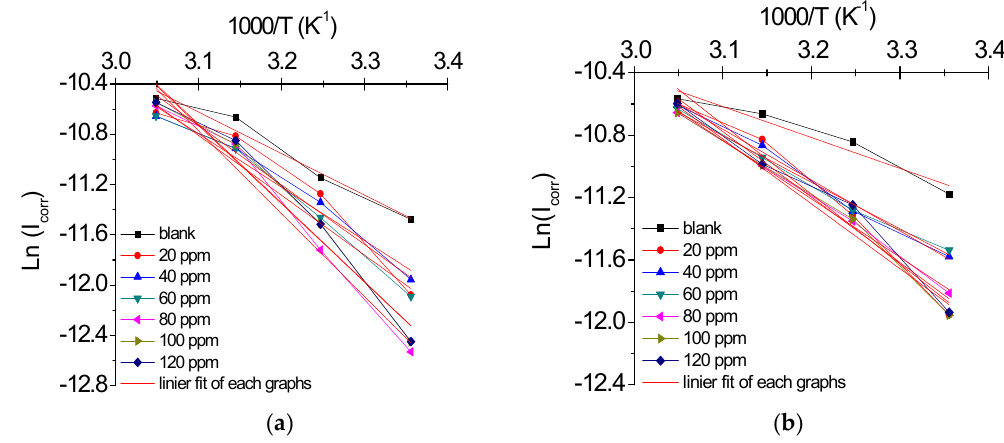
Figure 5. Graphs of the activation energy (E a ) determination (Ln(I corr ) towards the 1000 / T) subsequent to the addition of IL1 ( a ) and IL2 ( b ) in various concentrations. Table 5. E a corrosion reaction subsequent to the addition of IL1 and IL2 to 1% NaCl. E a (kJ / IL